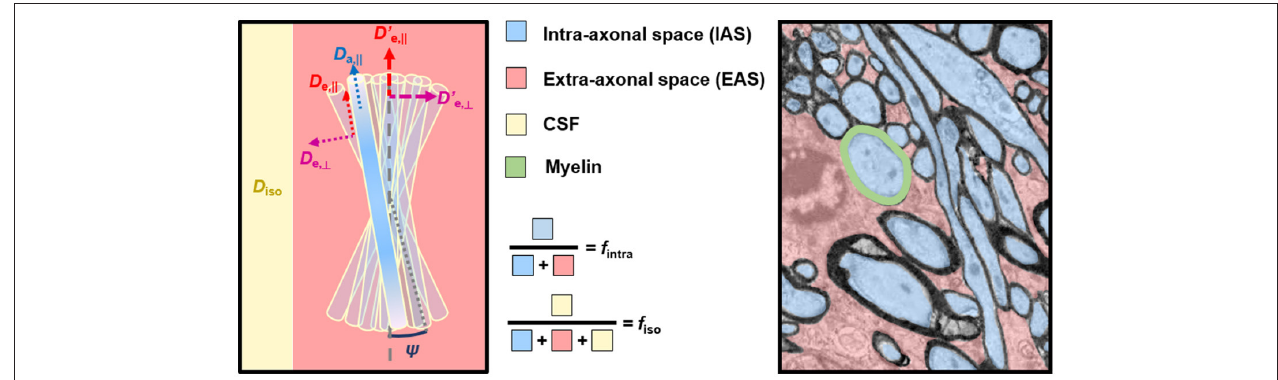
FIGURE 1 | Correspondence between model compartments (Left) and tissue components (Right) . (Left) Schematic of a typical three-compartment model with , are apparent extra-axonal diffusivities, depending how the model defines and D ′ e, relevant parameters. D e, and D e, are local extra-axonal diffusivities, and D ′ e, ⊥ k k ⊥ them. (Right) Cross-sectional electron microscopy image of a white matter bundle. Adapted from Mikula and Denk [39] with permission. While myelin is present in WM, it is absent from DWI models due to its short T 2